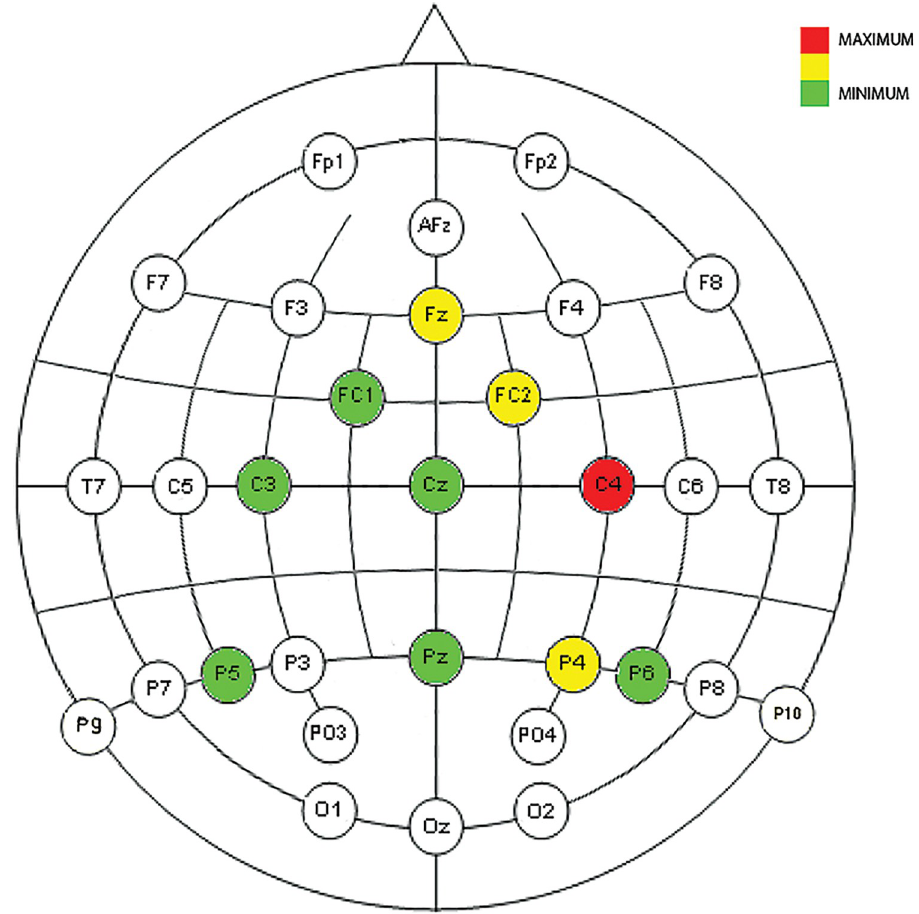
Fig 9. Neuronal distribution map of the electrodes that detect correlated, dependent, and significant monotonous slopes in the power change for all four ASFs in low delta between 438 ms and 750 ms.